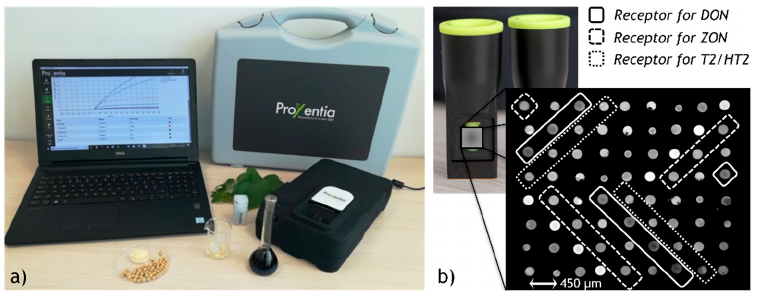
Figure 2. The system overview: ( a ) The PRX system was composed of three elements: (I) a universal reader able to read a series of (II) cartridges that incorporate the RPI technology, and (III) a software that analyzes the data and returns the results of the analysis to the user. ( b ) The cartridges and their surfaces for mycotoxins analysis in wheat. Receptors for mycotoxins are highlighted, whereas unmarked receptors are calibrators plus negative and positive controls. The figure is based on author’s photographs.